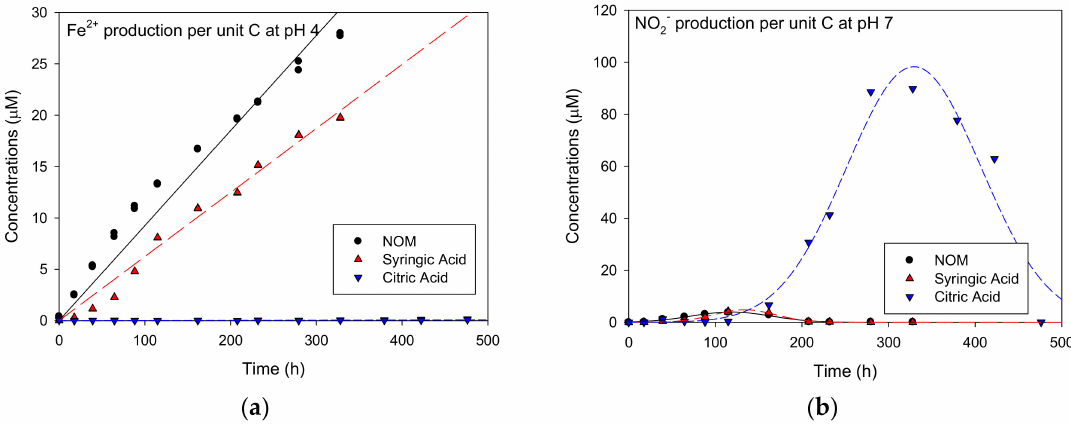
Figure 4. The total organic carbon (TOC)-normalized Fe 2 + and NO 2 − concentrations via time at ( a ) pH 4 and ( b ) pH